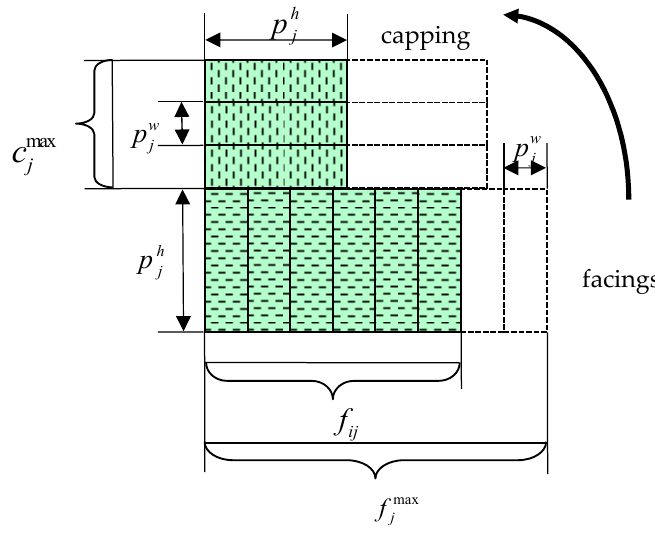
Figure 3. Allocation of caps.